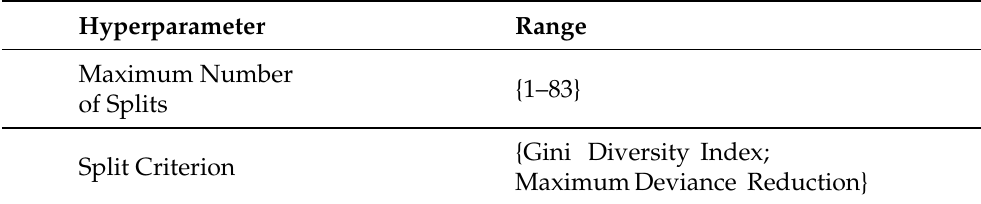
Table 7. Hyperparameter configuration—decision tree.